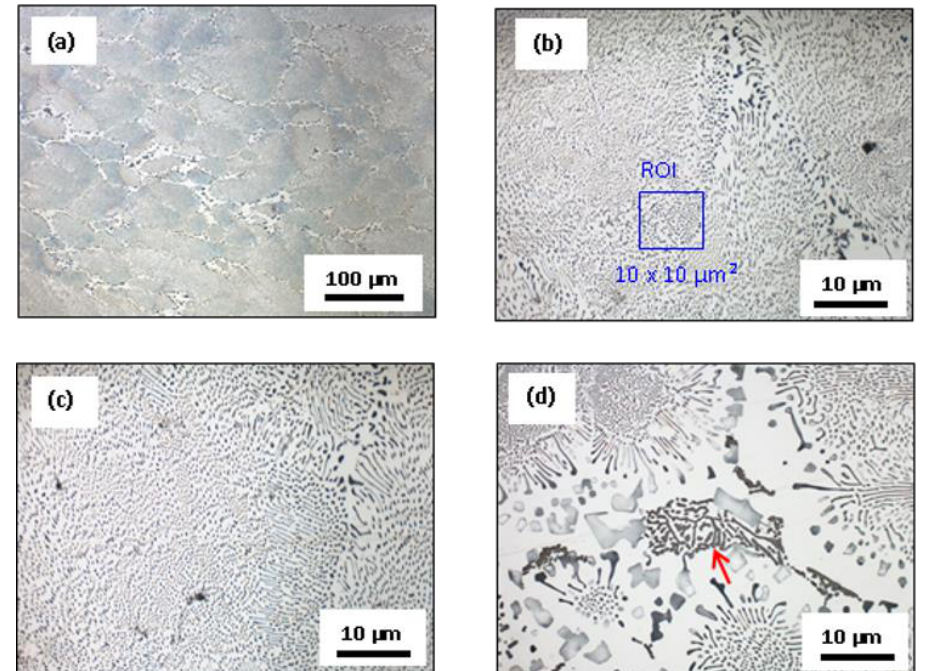
Figure 6. Microstructure of the Al-13.1 wt.% Mg 2 Si eutectic at a 350 °C mold temperature, ( a ) at a lower magnification and ( b – d ) at higher magnifications. The red arrow indicates the presence of a ternary eutectic.